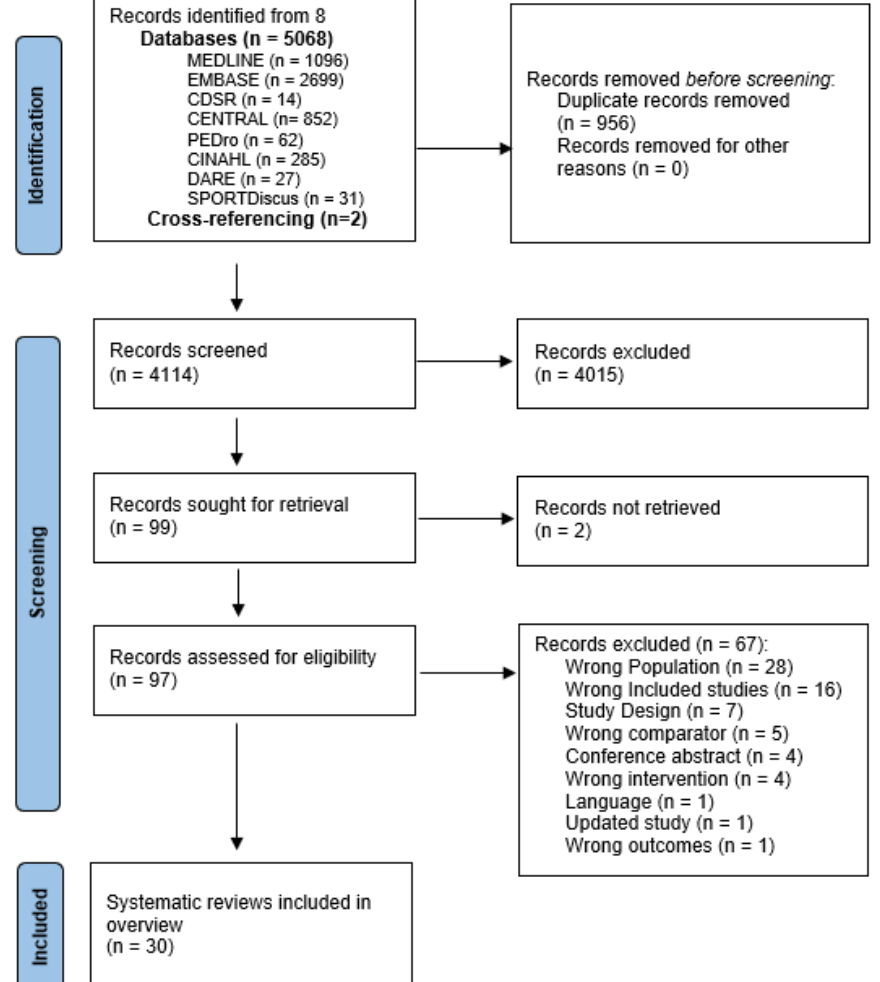
Figure 1. Overview Figure 1. Overview flowchart.